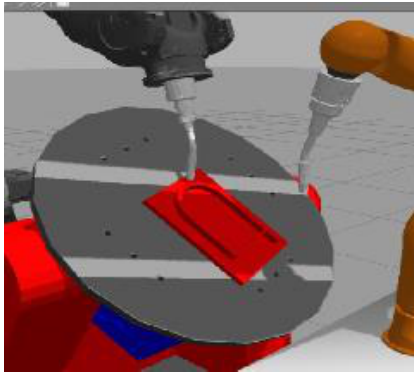
Figure 10. Workpiece 2, robots, and turn table simulated in GAZEBO.